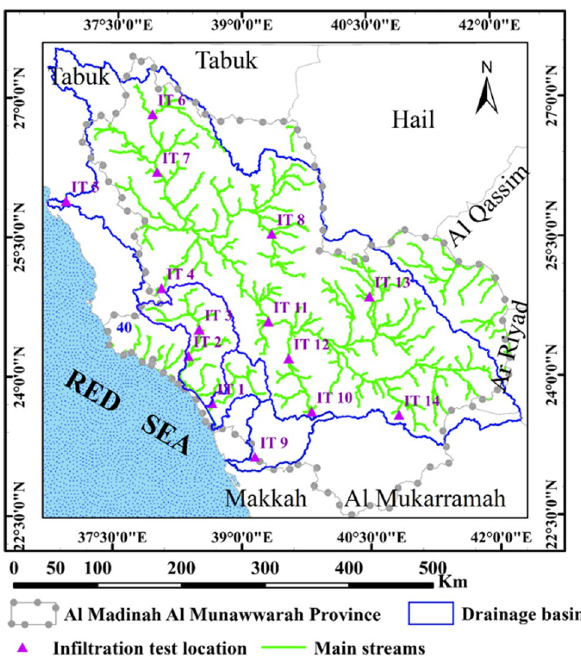
Fig. 5 Location map of the infiltration test in the study drainage basins